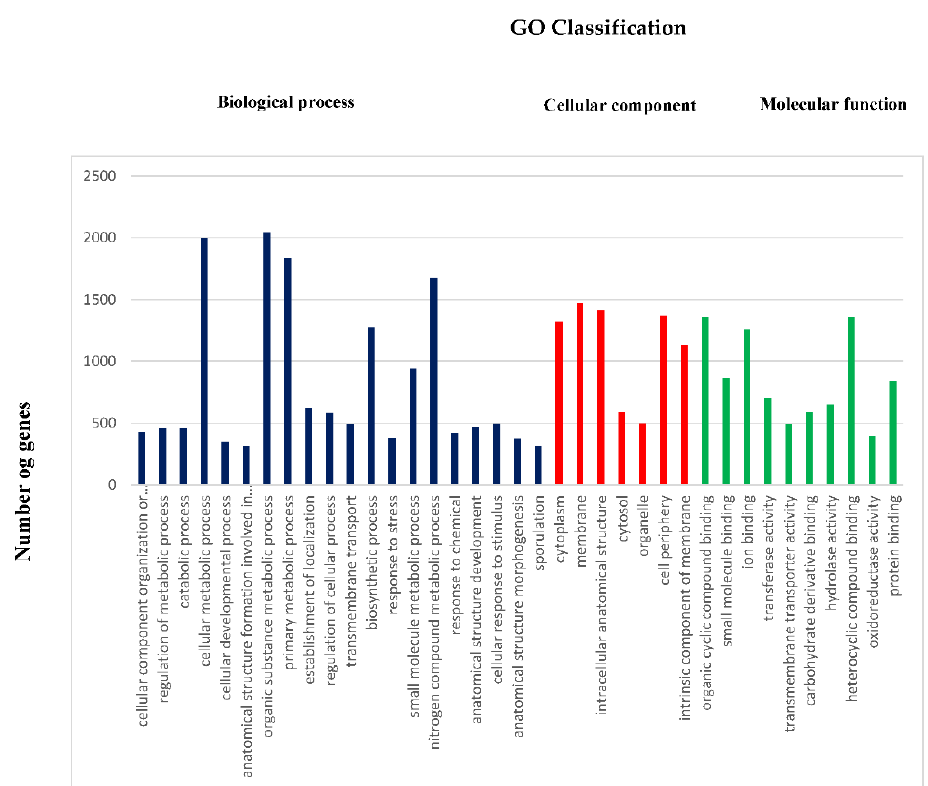
Figure 5. Gene ontology (GO) annotation and functional classification of Bacillus subtilis Bbv57. Functional categorization using gene ontology (GO) terms was performed based on the Blastx hits from the nr database using Blast 2 GO annotation in OMICSBOX 2.0.10.